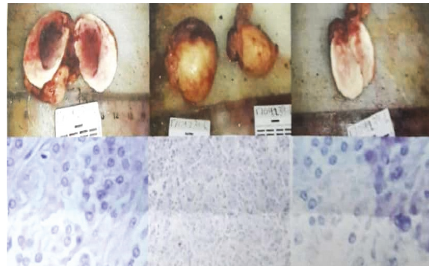
Figure 5: Upper left shows Leydig cell tumor of the right ovary. Upper right shows normal left ovary; microscopic examination shows cells abundant eosinophilic cytoplasm. Reinke crystals are